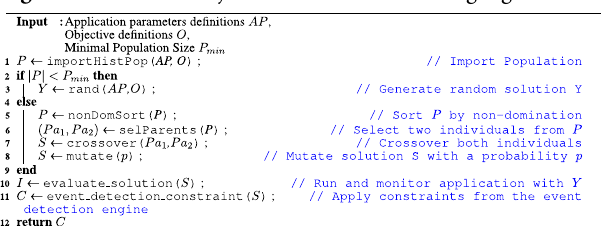
Algorithm 1. Multi-objective ASPIDE autotuning algorithm